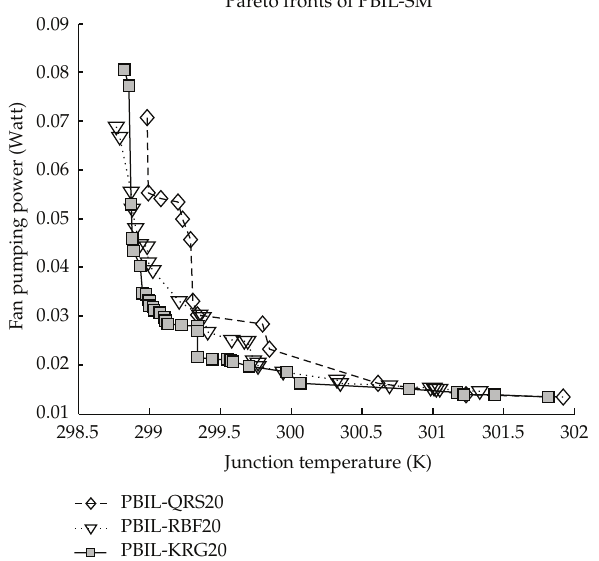
Figure 5: Pareto fronts from surrogate-assisted